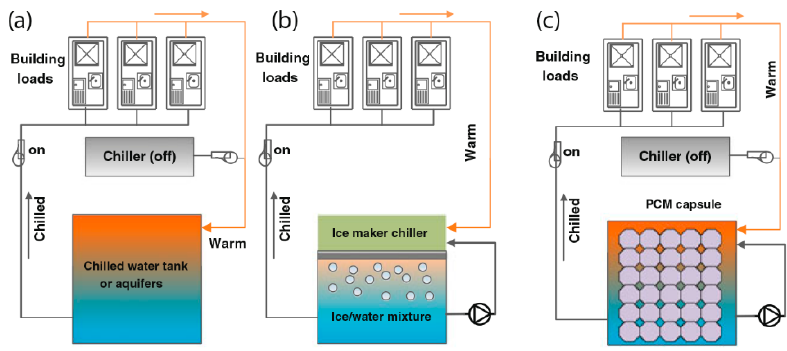
Figure 6. ( a ) Chilled water tank for air conditioning; ( b ) Ice storage tank for air conditioning ( c ) PCM storage tank for air conditioning. Reproduced with permission from [90]. Springer: Energy Solutions to Combat Global Warming, copyright 2016.